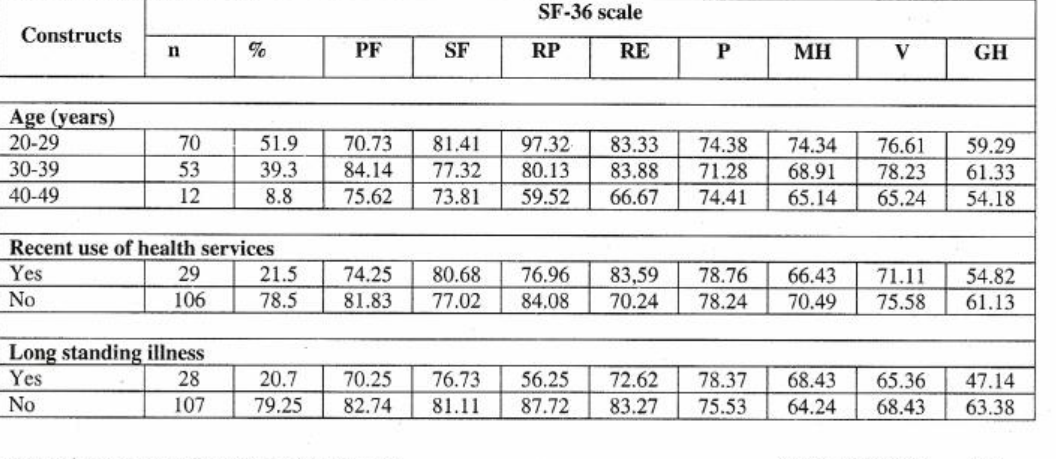
Table 6 : Mean scores on dimensions of SF-36 in relation to some socio-demographicvariables and use of health services in comparison